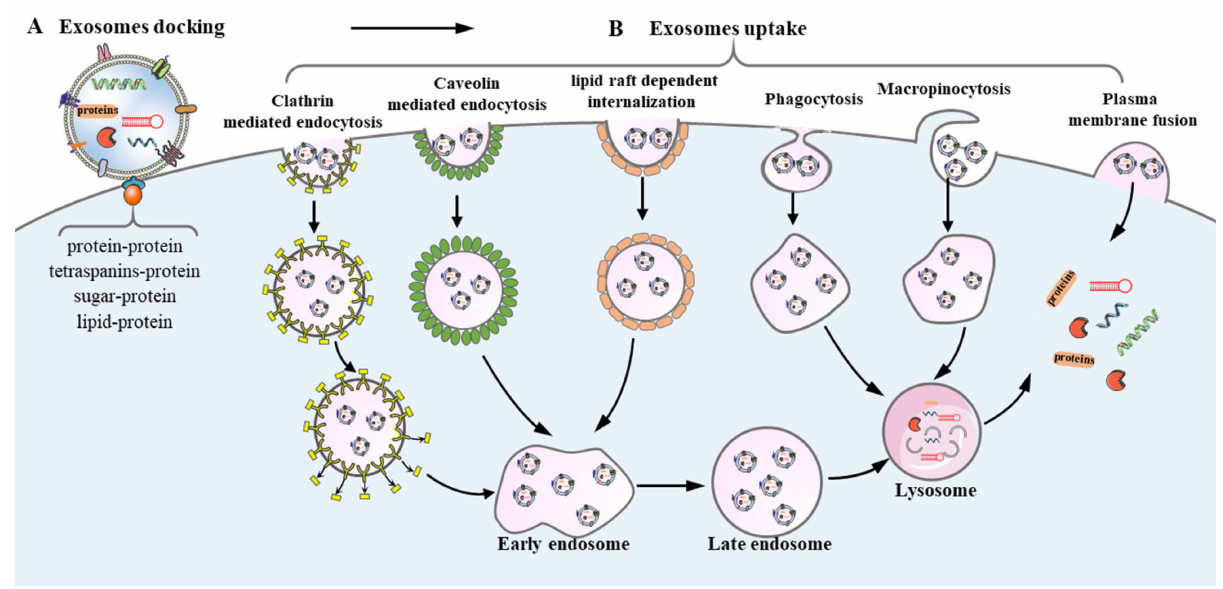
Figure 3. Mechanisms of Exosome Uptake. ( A ) When exosomes reach the recipient cells, they can dock at the plasma membrane of the recipient cells through the interaction between exosomal surface proteins and receptors on recipient cells. ( B ) After that, the exosomes may be taken up by recipient cells via the endocytosis route (clathrin mediated endocytosis and caveolin-mediated endocytosis), phagocytosis micropinocytosis, receptor-mediated endocytosis, as well as by direct fusion with the plasma membrane, which causes the release of the contents into the